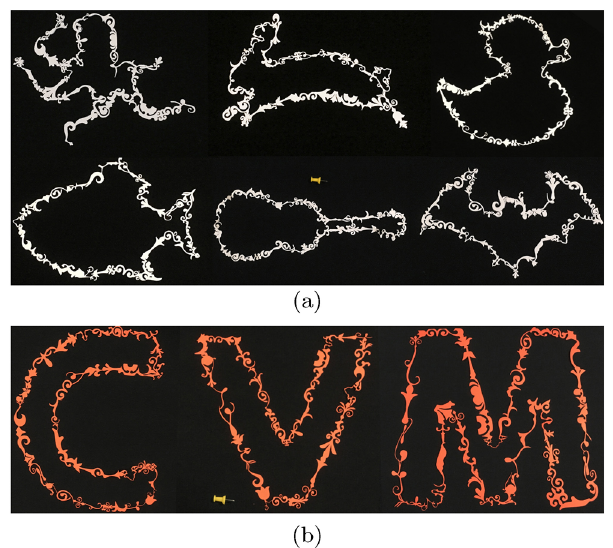
Fig. 13 Physical results fabricated by an FDM 3D printer (a) and a laser engraving machine